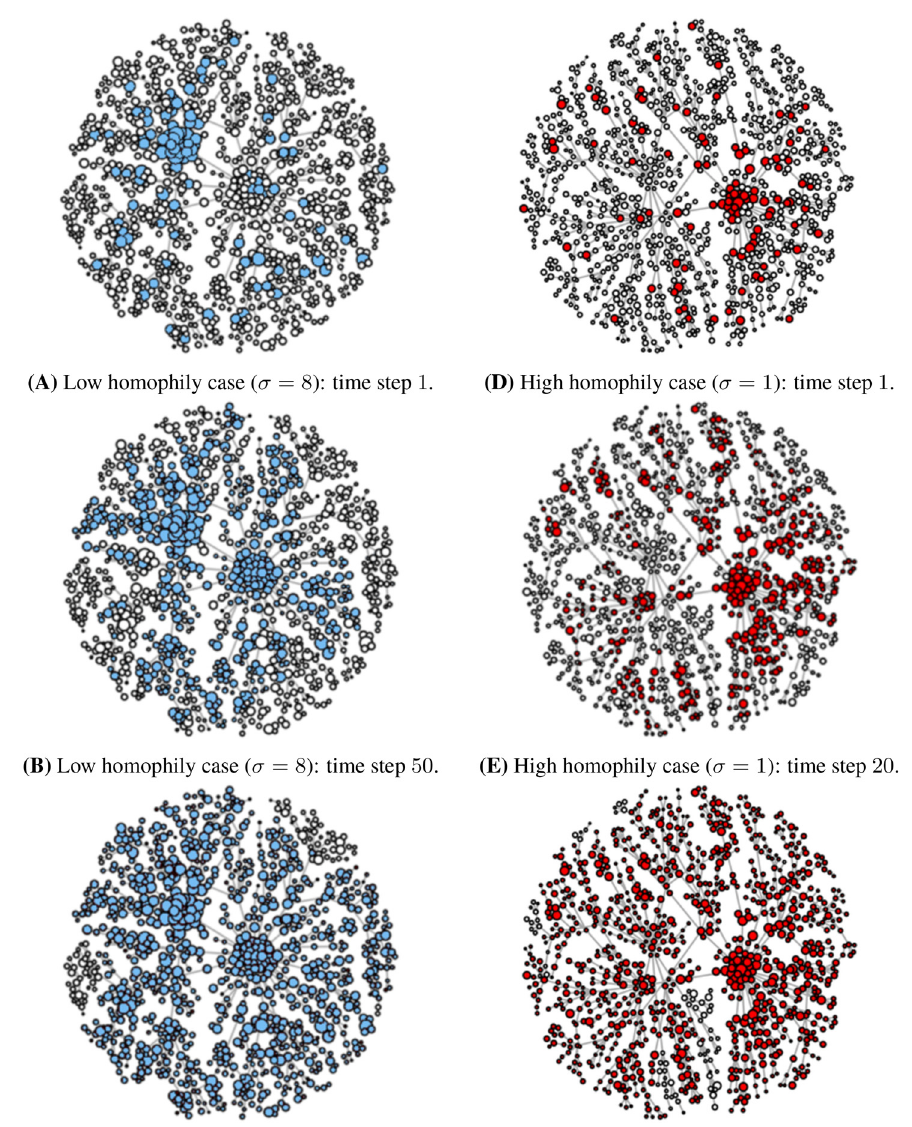
Fig 6. Temporal evolution of cooperation. The figure highlights the microscopic emergence of cooperation in the evolutionary process. The formation of cooperative groups in the network and also the group size depend on the homophily value. Figs A , B , C — in the low homophily case ( σ = 8), the defective behaviour tends to persist more in the population, not favouring the formation of cooperative groups and globally slowing the emergence of cooperation. Yet, the group size will be smaller in this case of low homophily. Figs D , E , F — in the high homophily case ( σ = 1), the convergence towards cooperation becomes quicker, and there is a natural formation of larger cooperative groups than in low homophily case. Analysing the corresponding figures of the evolution, we see clearly this difference, both in speed and size, in the formation of cooperative